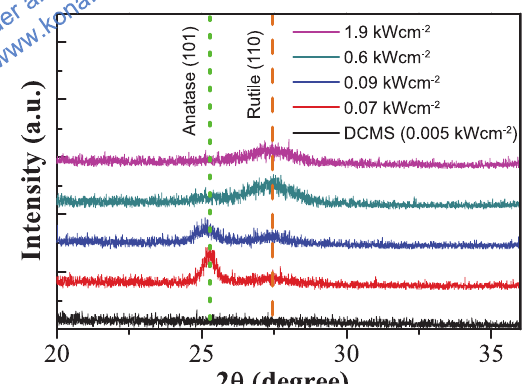
Fig. 5 Sketch of the experimental set-up, HC: hollow cathode, AR: anode ring, M: mesh, and S: